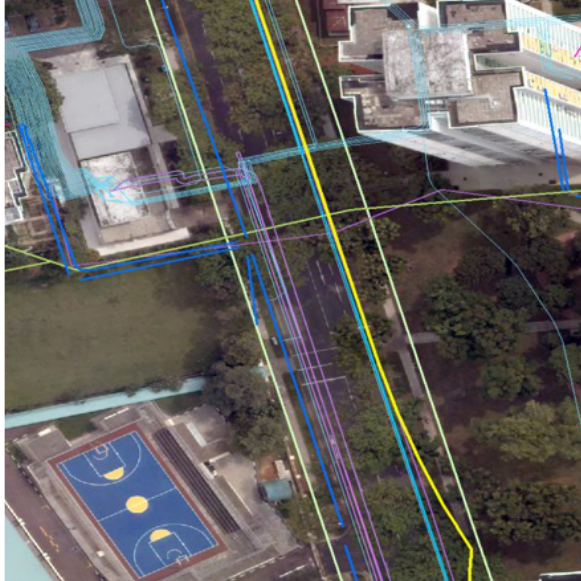
Figure 5. Available map data on existing utilities in highlighted area, Ang Mo Kio.